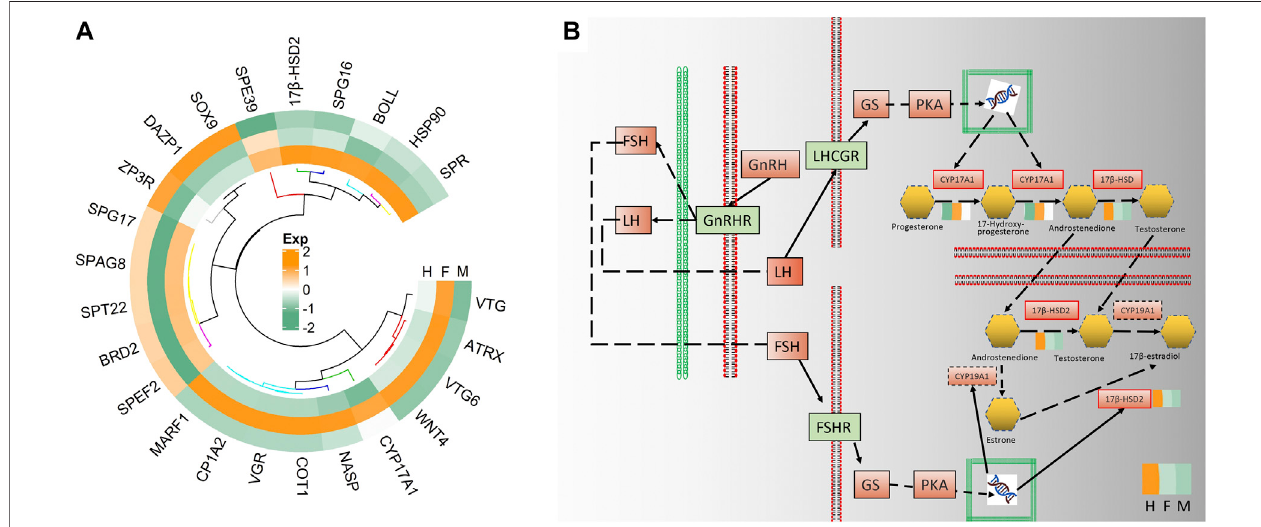
FIGURE 7 | (A) The circle heatmap showed the expression level of the screened genes related to hermaphroditism. (B) The solid line and dotted line predicted interactions are displayed as gene-gene interactions; The solid line border indicates that the gene has been annotated, and the red solid line border indicates that the gene is a differentially expressed gene. The color blocks around the differentially expressed gene are the expression levels of the gene in the three types of